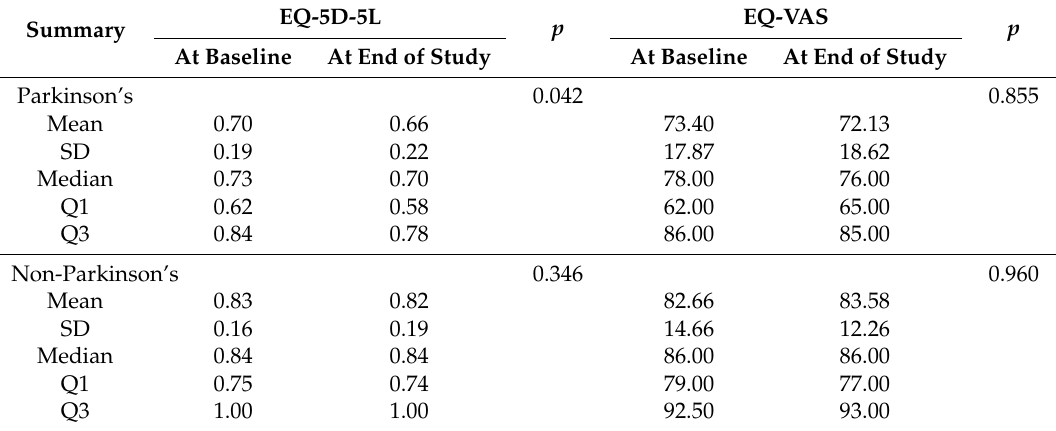
Table 3. Summary of EQ-5D-5L values and EQ visual analogue scale (VAS) scores at baseline and the end of study ( n = 563).